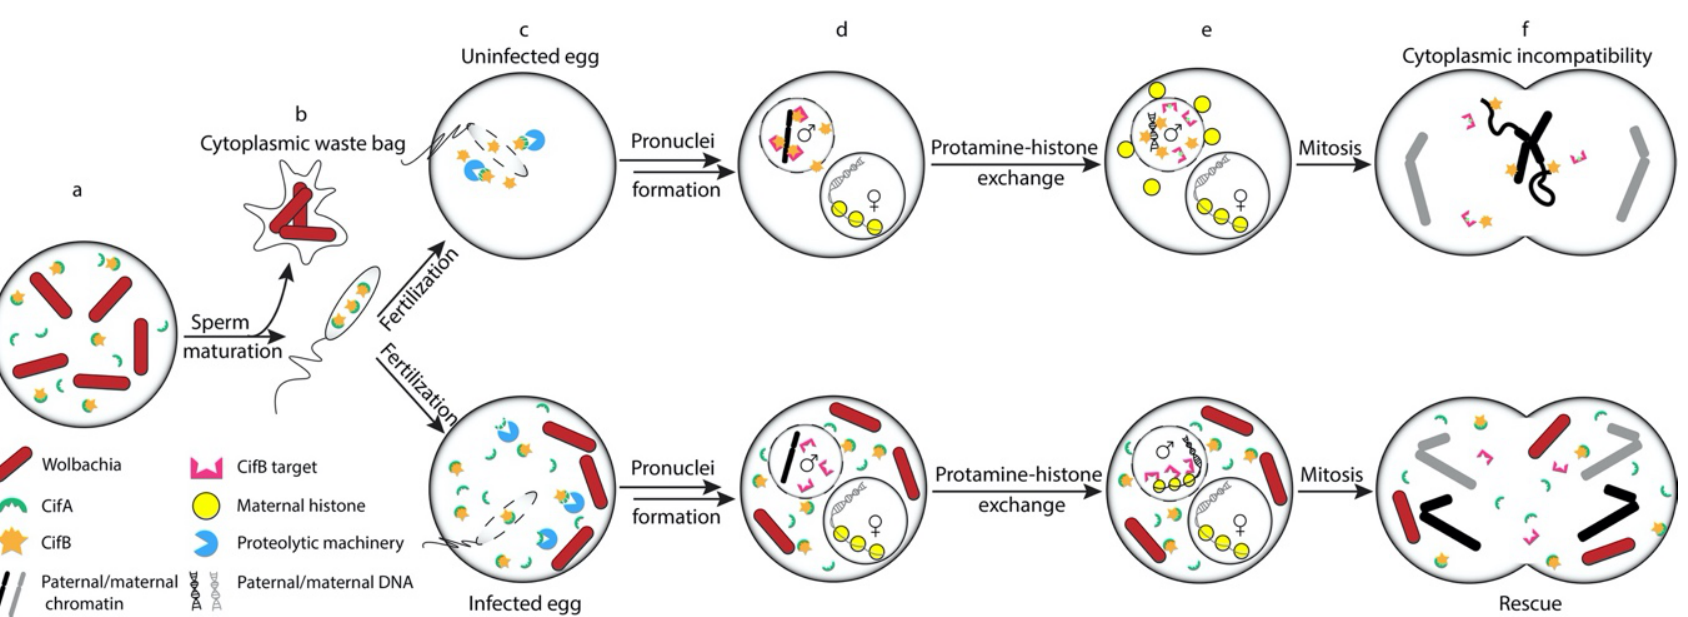
Figure 3. Hypothetical molecular mechanism of CI and rescue by the Wolbachia CI factors based on the TA model. a. Wolbachia CifA and CifB proteins are secreted into the host testis cells. Under normal conditions, CifA binds tightly to CifB to inhibit its premature action during spermatogenesis and facilitate its delivery to the sperm. b. During spermiogenesis, Wolbachia are shed from the mature sperm while CifA and CifB proteins remain in the sperm. c. Upon fertilization, CifA is rapidly degraded by a protease(s). Free CifB protein is now active (Top) unless the egg is infected by the same (or a compatible) strain of Wolbachia that can supply the embryo with fresh CifA protein (Bottom). d. (Top) In an uninfected egg, free CifB likely localizes to the paternal pronucleus where it can interact with paternal chromatin and modify its target(s). (Bottom) If the egg is infected with a compatible strain of Wolbachia , newly synthesized CifA secreted by the bacteria changes the localization of CifB through direct protein–protein interaction, preventing CifB from accessing its target(s). e. (Top) CifB modification of the target (shown as green star on the target) results in aberrant histone deposition and other downstream defects in the paternal pronucleus. (Bottom) CifB neutralization by CifA results in normal protamine–histone exchange in the paternal pronucleus. f. (Top) Improper condensation of the paternal chromosome leads to chromosome mis-segregation during anaphase with chromatin bridging and shearing of paternal DNA. (Bottom) Properly condensed paternal chromosomes in the “rescued” embryo allows for normal mitotic division.